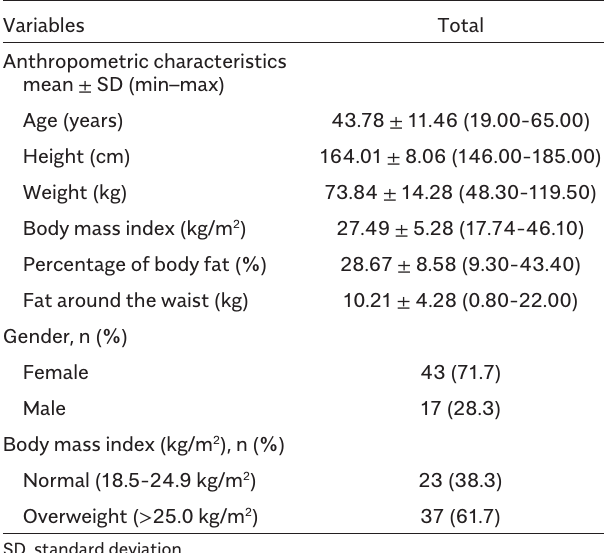
Table 1. Descriptive Characteristics of the Participants Variables